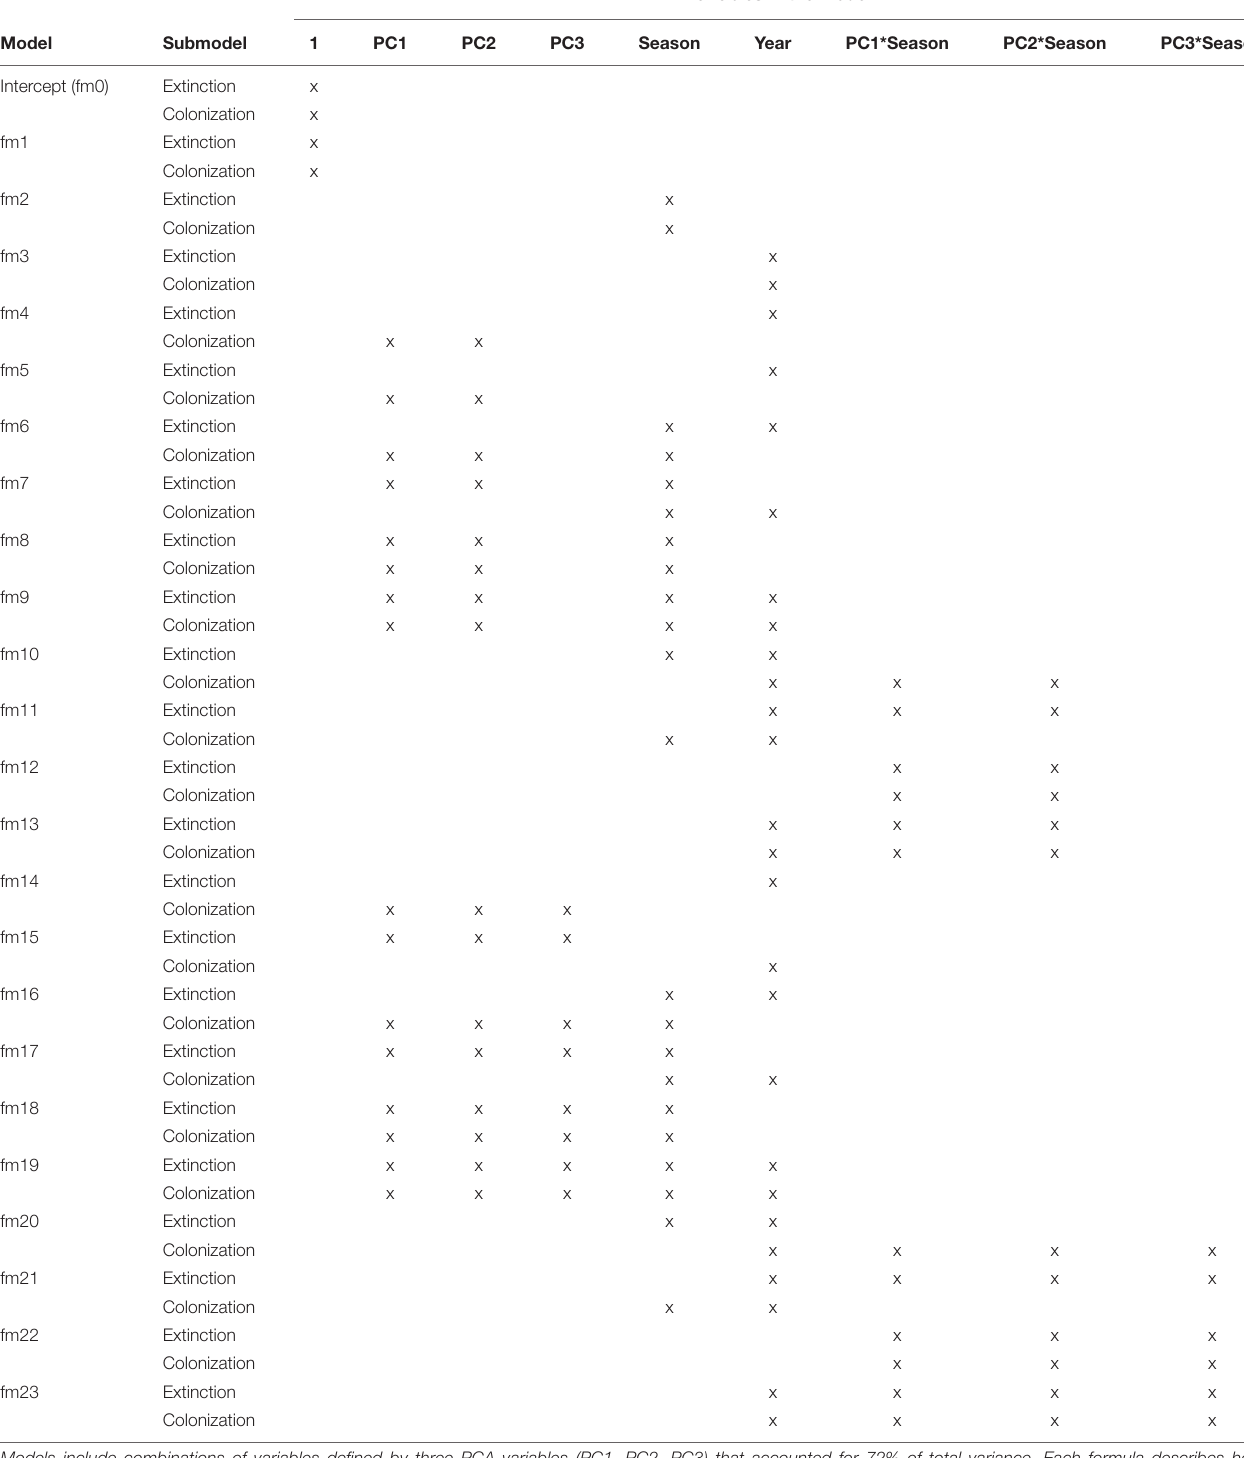
Models include combinations of variables defined by three PCA variables (PC1, PC2, PC3) that accounted for 72% of total variance. Each formula describes how colonization probability and extinction probability were modeled as a function of the different resources within each PCA variable. Seasons related to tick behavior